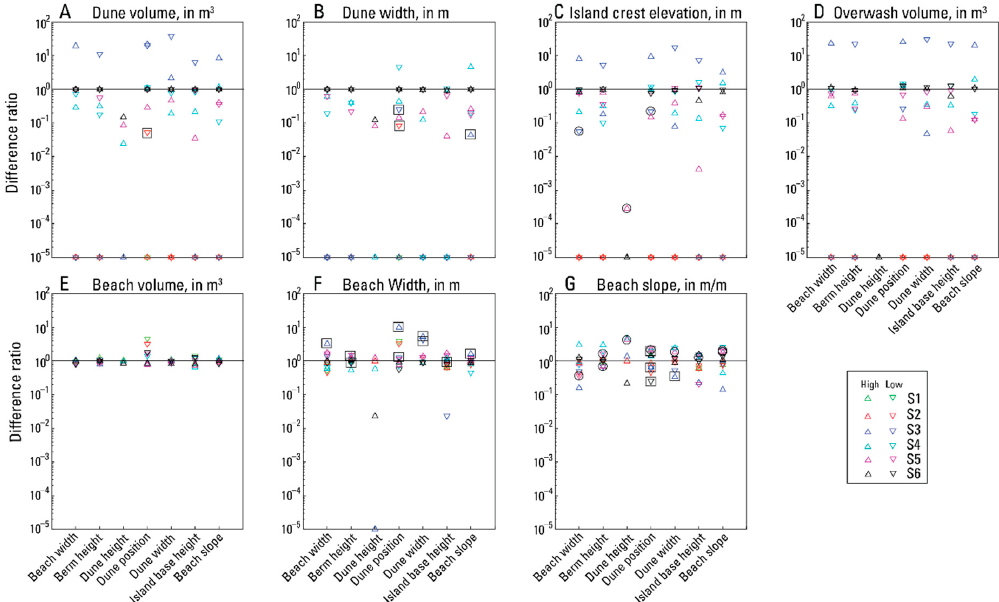
Figure 12. 1D difference ratio of percent change of dune volume ( A ), dune width ( B ), island crest elevation ( C ), overwash volume ( D ), beach volume ( E ), beach width ( F ), and beach slope ( G ) of the baseline and modified profiles; note circled markers around storms markers (S1–S6) indicate a negative relative response difference. Black squares indicate the pre- to post-storm difference in the baseline simulation was 0 or positive and black circles indicate the pre- to post-storm difference in the baseline simulation was negative. Horizontal black line indicates a difference ratio of 1; undefined or 0 ratio values were set to 10 − 5 for inclusion in the figures.